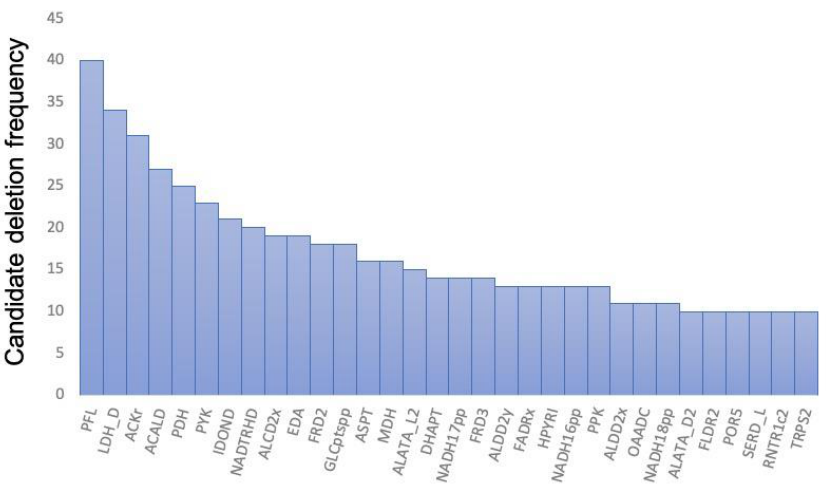
Figure 3. Top 32 reactions that were most frequently identified as candidates for deletion in the production of target compounds and their respective frequencies. A total of 32 reactions were selected in order of frequency of selection of 189 reactions that could have potentially been deleted for the production of 52 compounds. For example, the deletion of pyruvate-formate lyase (PFL), which was observed at the highest frequency, was required for 40 of the 52 compounds. The abbreviations, descriptions, and reactions are the same as in the iJO1366 model